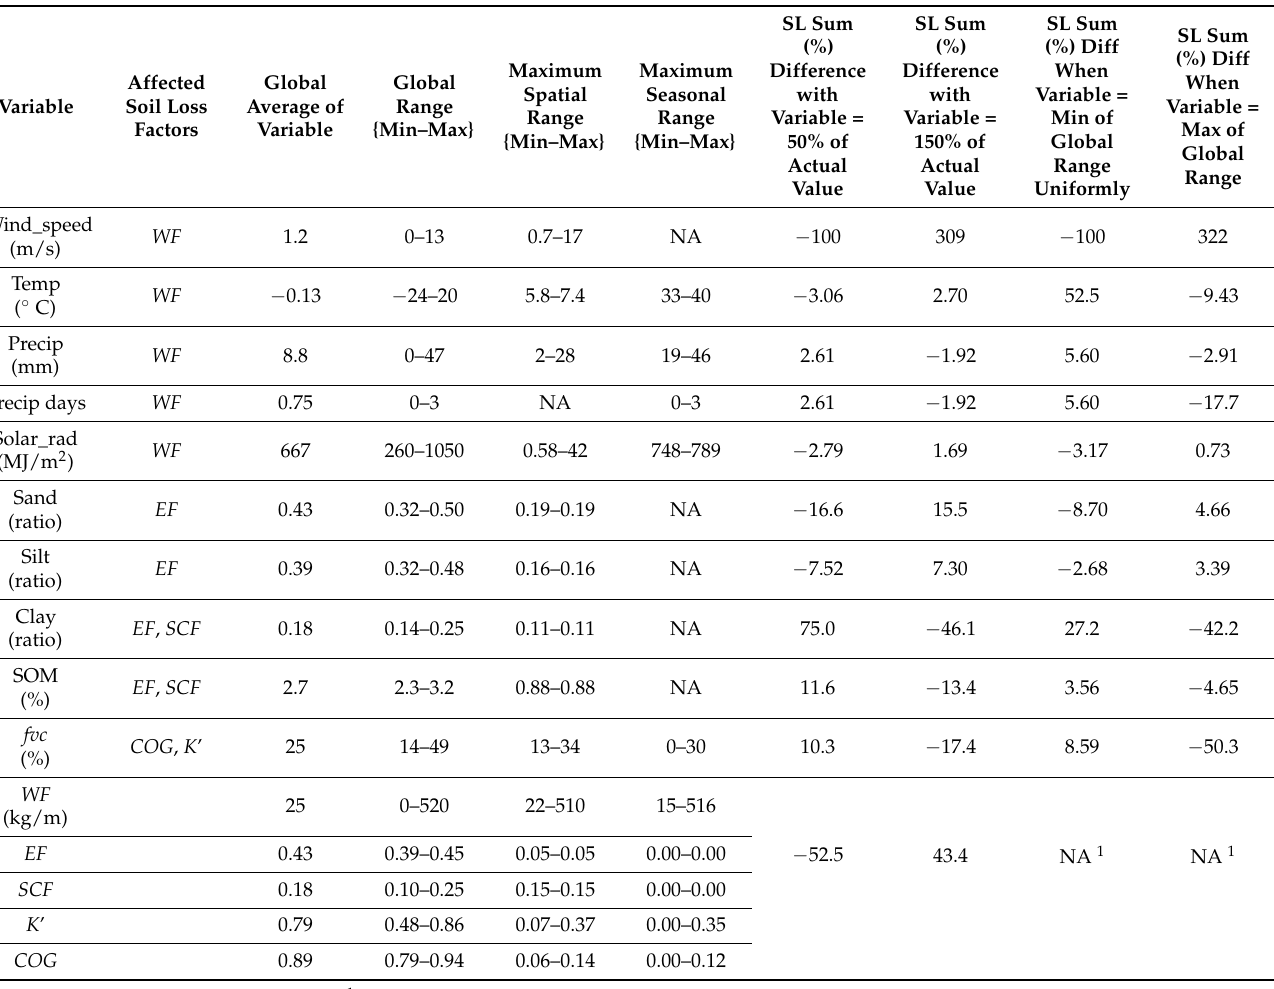
Table 2. Sensitivity analysis of soil loss ( SL ) against model inputs. Sensitivity was measured as the perfect change in the annual, spatial soil loss sum if an input increased or decreased by a percentage of the original value, or was uniformly set to the minimum or maximum value of the spatial data. The actual annual soil loss rate was 8800 t/km 2